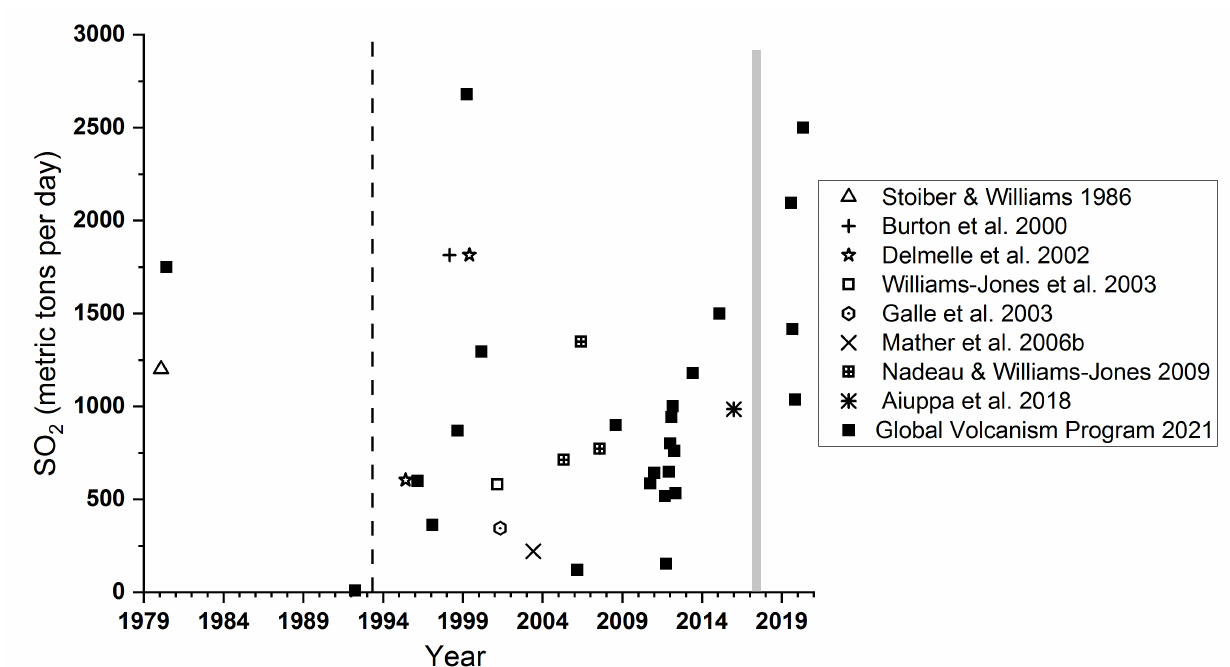
Figure 1: SO emissions from Santiago crater, Masaya volcano, from 1979 to 2020. Black dashed line indicates 2 initiation of gas crisis in May 1993. Grey shaded area indicates the AQMesh downwind measurement period (this study) from February to August 2017. SO emissions data sourced from Stoiber et al. [1986], Burton et al. 2